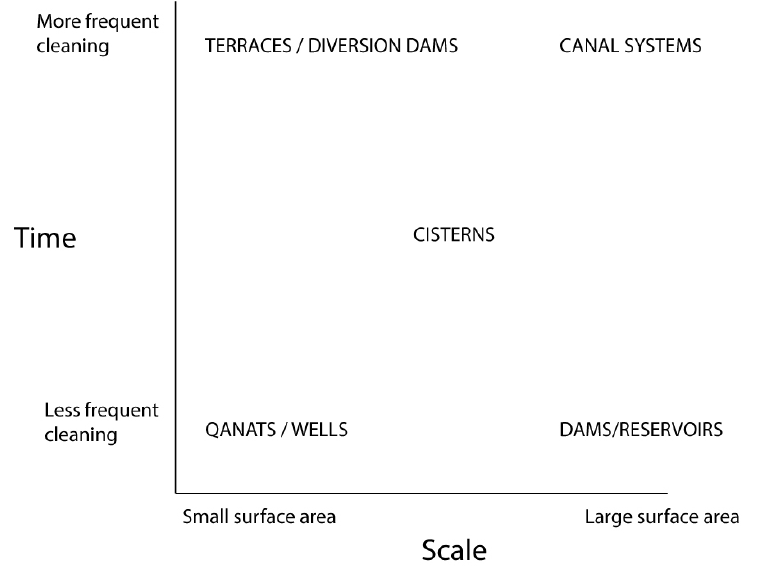
Figure 5. Schematic representation of the relationship of time and scale, with various kinds of water supply structures